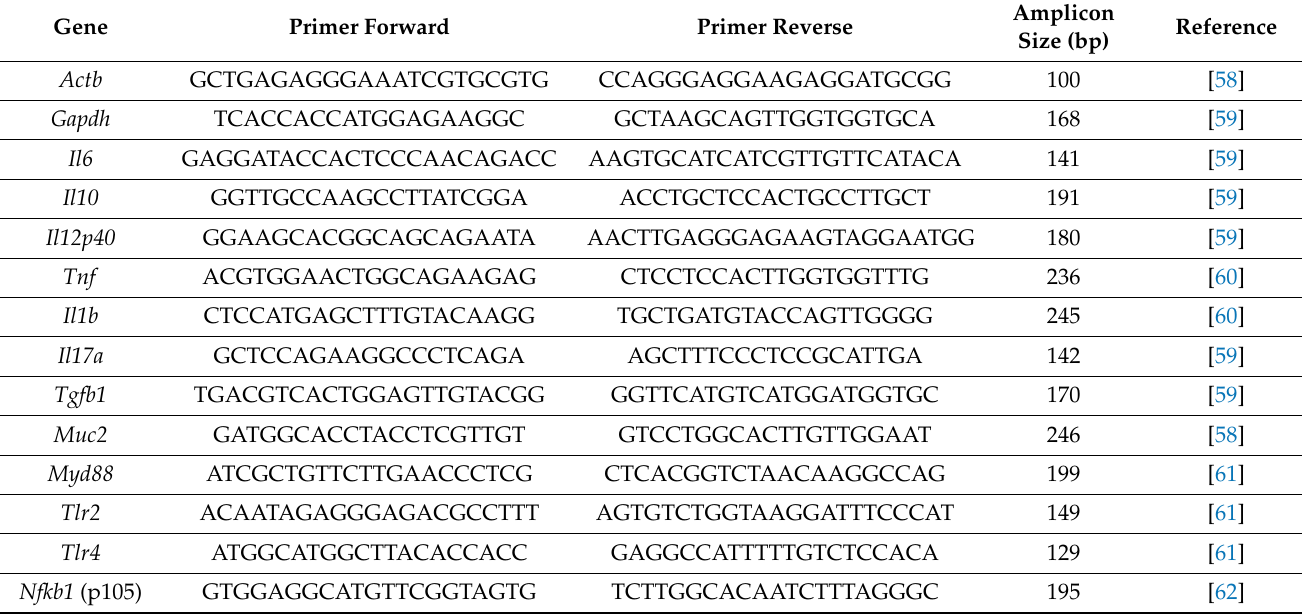
Table 2. Quantitative Polymerase Chain Reaction (qPCR) primers used in this study.